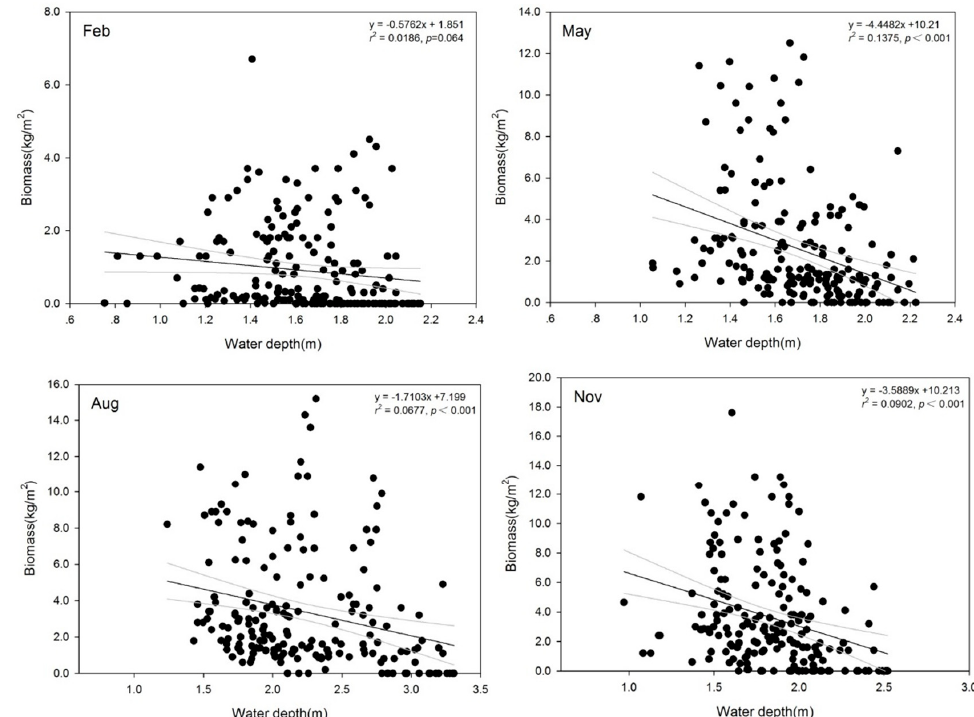
Figure 6. Correlation between the biomass of submerged aquatic plants and corresponding water depth from 2013 to 2017.